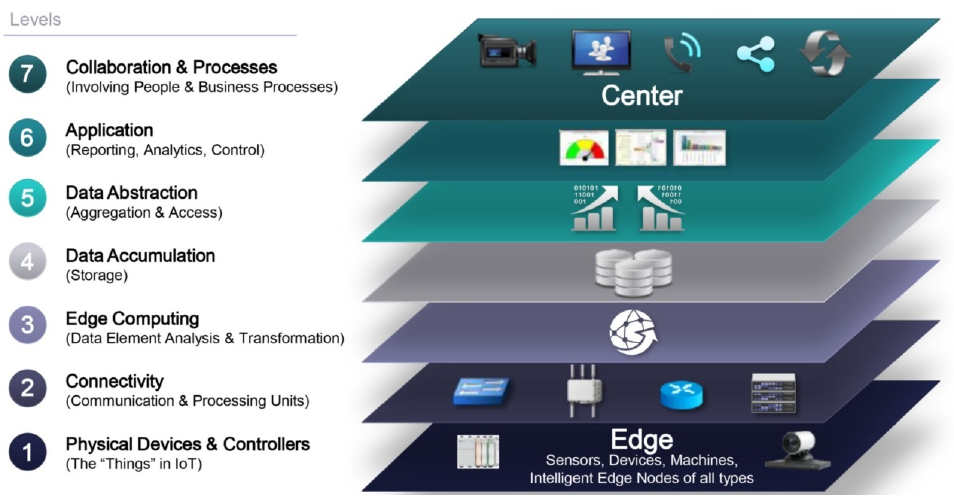
Figure 1. IoT reference model